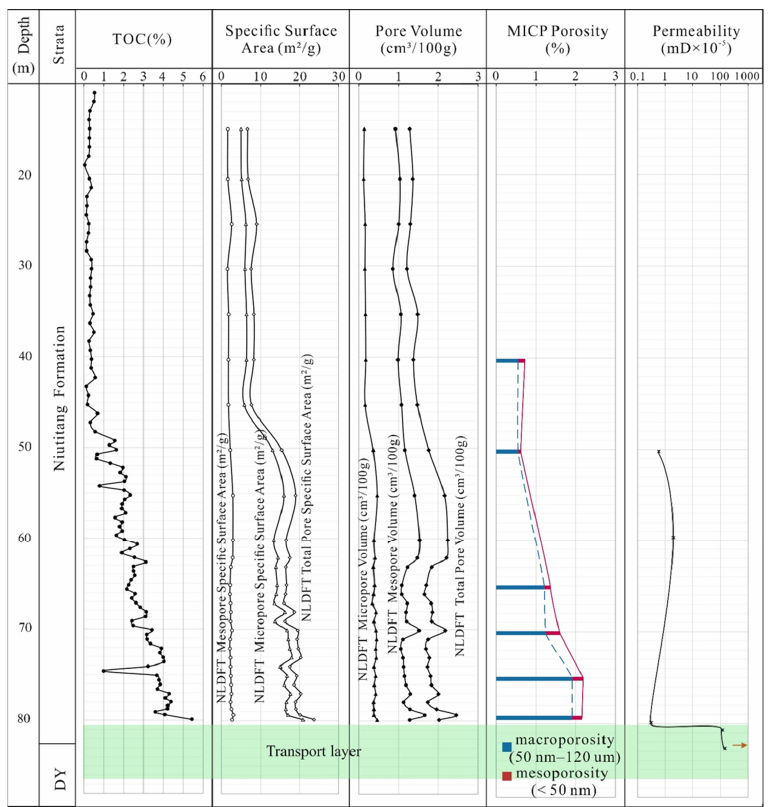
Figure 6. Depth profiles of the total organic carbon (TOC) content, nonlocal density functional theory (NLDFT) specific surface area, NLDFT pore volume, mercury injection capillary pressure (MICP) porosity and permeability of the Niutitang shale in the JDS-1 well. The blue dashed line and red solid line denote the overall trends of macroporosity (50 nm to 120 μ m) and mesoporosity (<50 nm) measured using high-pressure Hg porosimetry. The floor interval with high permeability (as the transport layer) is shown in green. DY = Dengying.